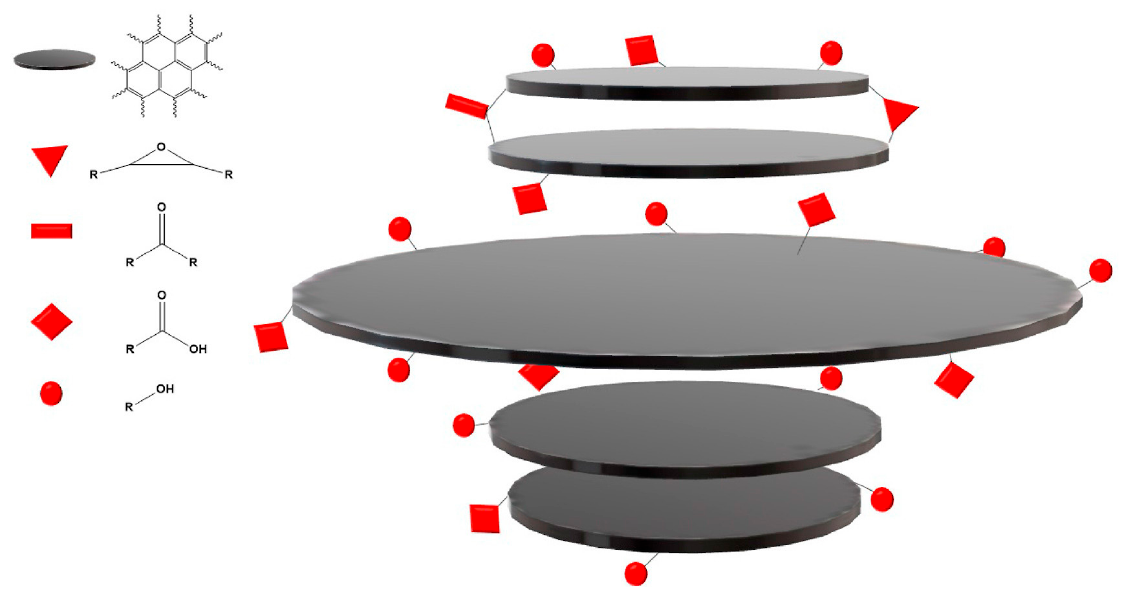
Figure 5. Schematic structure of GQDs. Reprinted with permission from Mintz et al. [109].